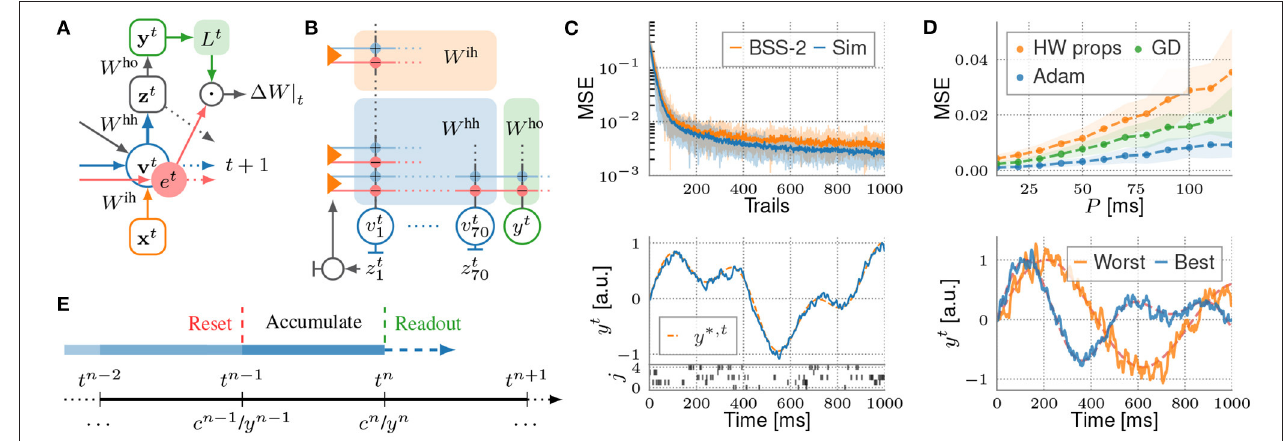
FIGURE 10 | (A) Computational graph of an RSNN for one time step. The contribution to the weight update is computed by merging learning signals L t j with eligibility traces e t ji . (B) Representation of the RSNN on the BSS-2 system using signed synapses. Inputs and recurrent spike trains are routed to the corresponding synapse drivers via the crossbar. (C) s-prop training on hardware. The upper plot depicts the evolution of the MSE while training the BSS-2 system in-the-loop, where the experiment is executed on BSS-2 and weight updates are computed on the host computer, in comparison to training with the network simulated in software, incorporating basic hardware properties (Sim). In both cases the weights are optimized using the Adam optimizer (Kingma and Ba, 2014). The learned analog membrane trace of the readout neuron after training BSS-2 for 1,000 epochs is exemplified in the lower plot, aligned to the spike trains z t j of the first five out of 70 recurrent neurons. (D) NASProp simulations. The upper plot depicts the MSE over the update period P after training with Adam in comparison to a training with GD and a training taking additional hardware properties (noise, weight saturation, etc.) into account (HW props). Optimization with pure GD mimics weight updates computed by the SIMD CPU while on-chip learning. The lower plot shows the worst and best learned readout traces of the target pattern ensemble in simulation. (E) Timing of NASProp weight updates. For each update n at t n , the correlation c n ji are merged with the learning signals L n j by incorporating the membrane trace y n